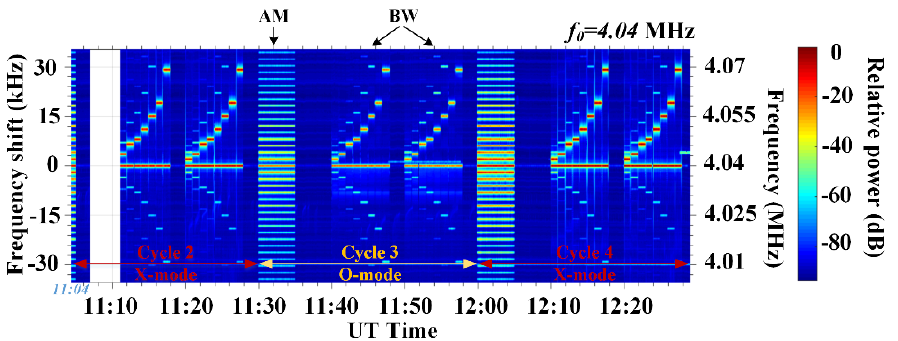
Figure 3. Variations of the SEE spectral structure where the frequency shifts from center frequency f 0 = 4.04 MHz.